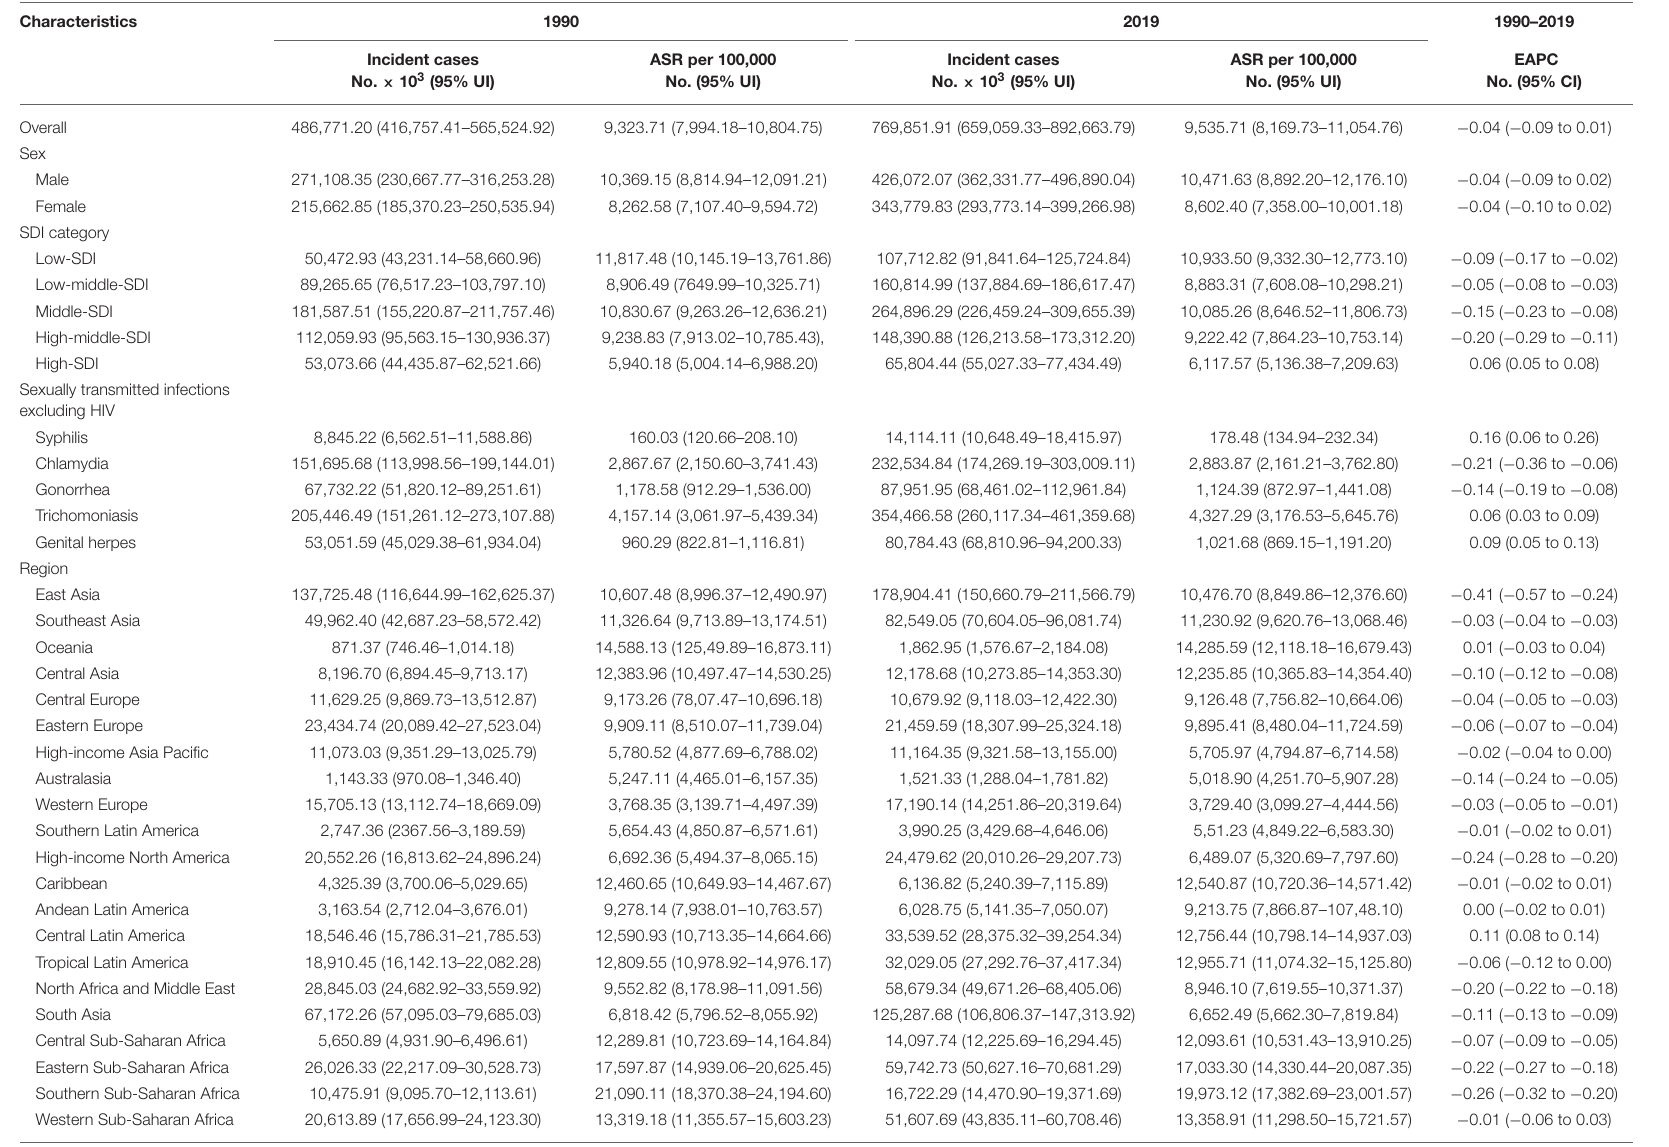
TABLE 1 | Incident cases and age-standardized incidence rates of sexually transmitted infections in 1990 and 2019 and estimated annual percentage change from 1990 to